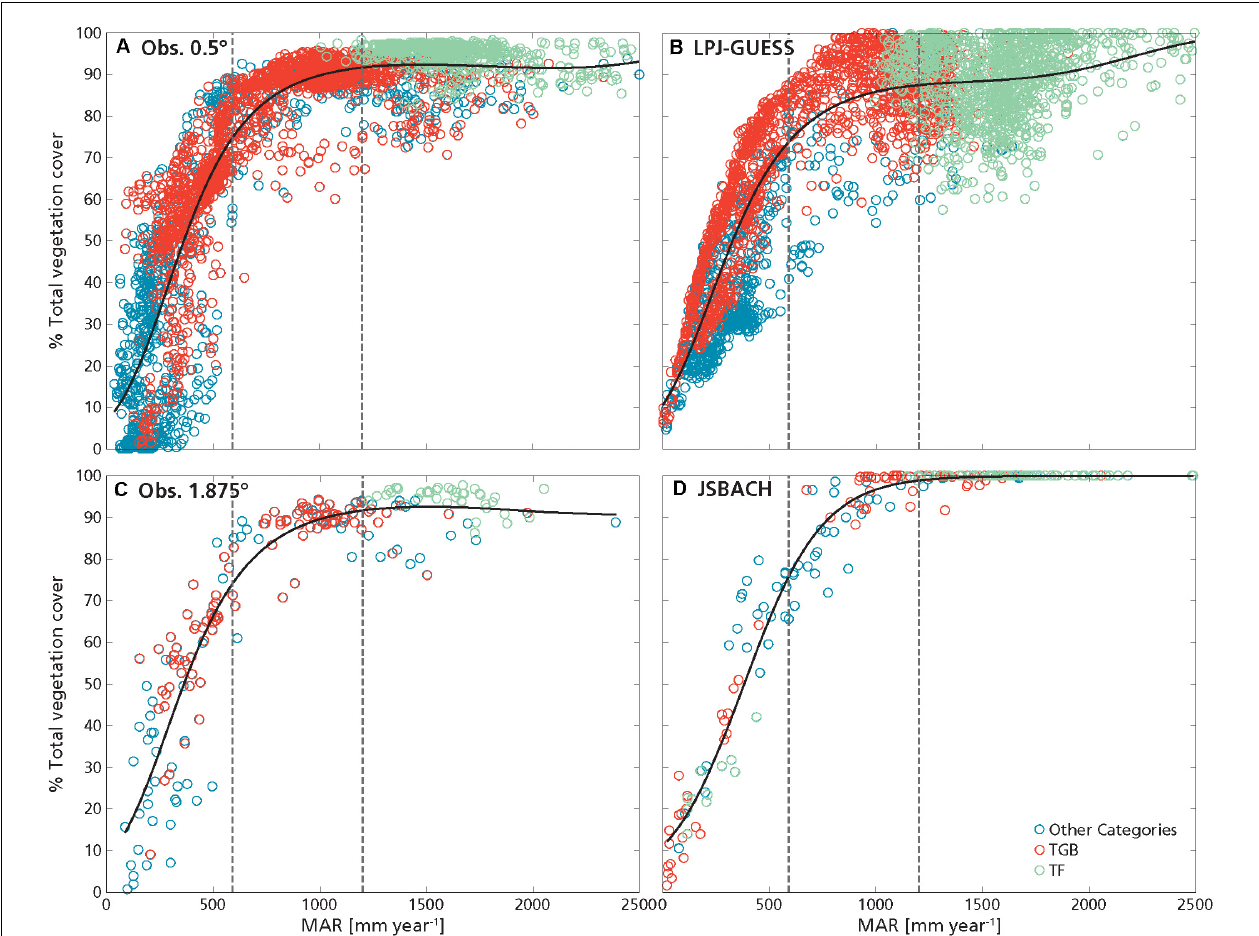
FIGURE 4 | Total vegetation cover (tree cover+grass cover) as a function of MAR: (A) obs. 0.5 ◦ , (B) LPJ-GUESS, (C) obs. 1.875 ◦ , and (D) JSBACH. Continuous lines are the best GLM fits of total vegetation cover with MAR (that was the best predictors for all datasets, see Table 1 ). Note that for Obs 1.875 ◦ we show the fit with MAR at third order (the second best fit after the one with MAR at the second order, (cid:49) AIC = 1.55), because they have similar predictive power but the fit with MAR 3 looks better in agreement with the observations ( Supplementary Table S5 ). Green circles are grid cells with predominance of tropical forest (TF), red circles with predominance of tropical grassy biome (TGB). Blue circles are grid cells with other or no predominant